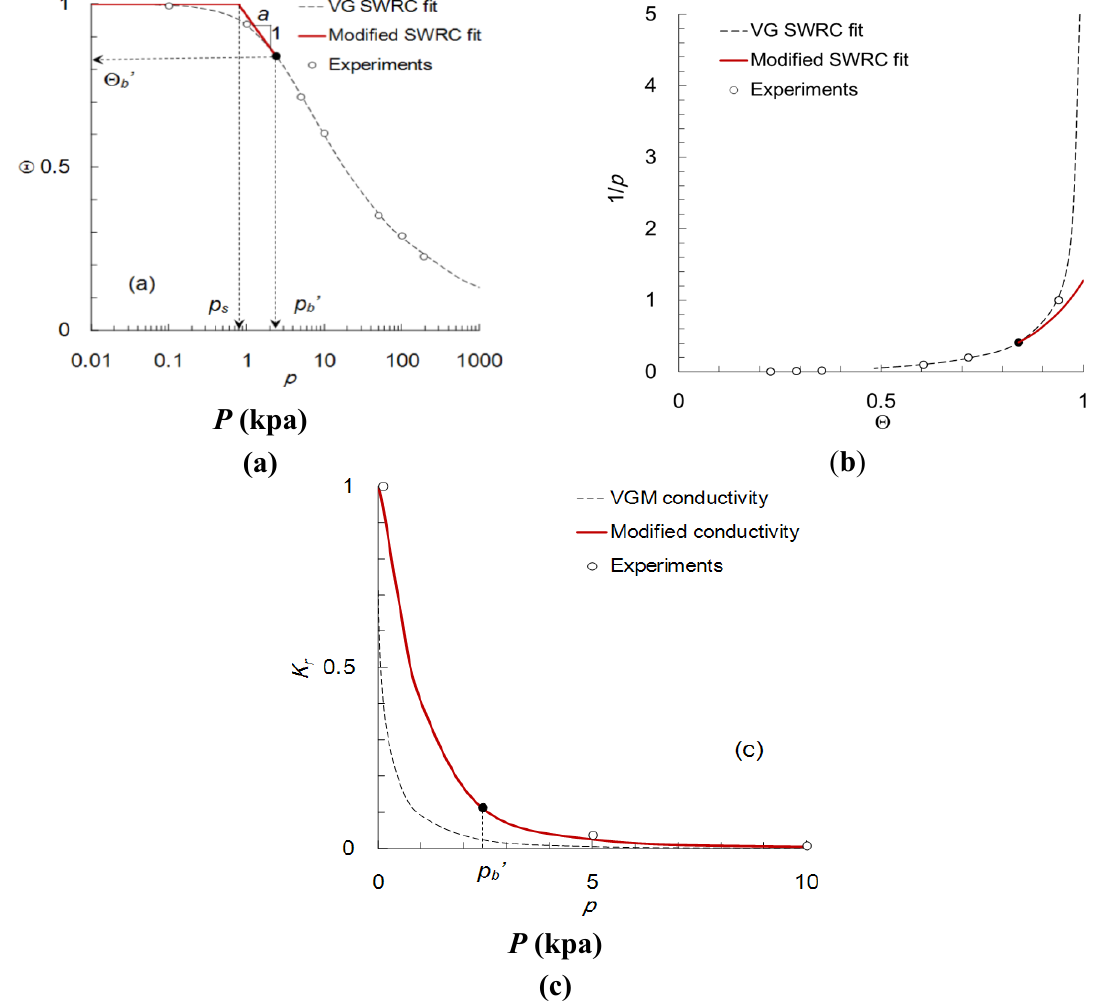
Figure 1. Comparison of the soil water retention curves and hydraulic conductivities in both van Genuchten-Mualem theory and its modification: ( a ) soil water retention curves; ( b ) 1/ p - Θ relationships; and ( c ) hydraulic